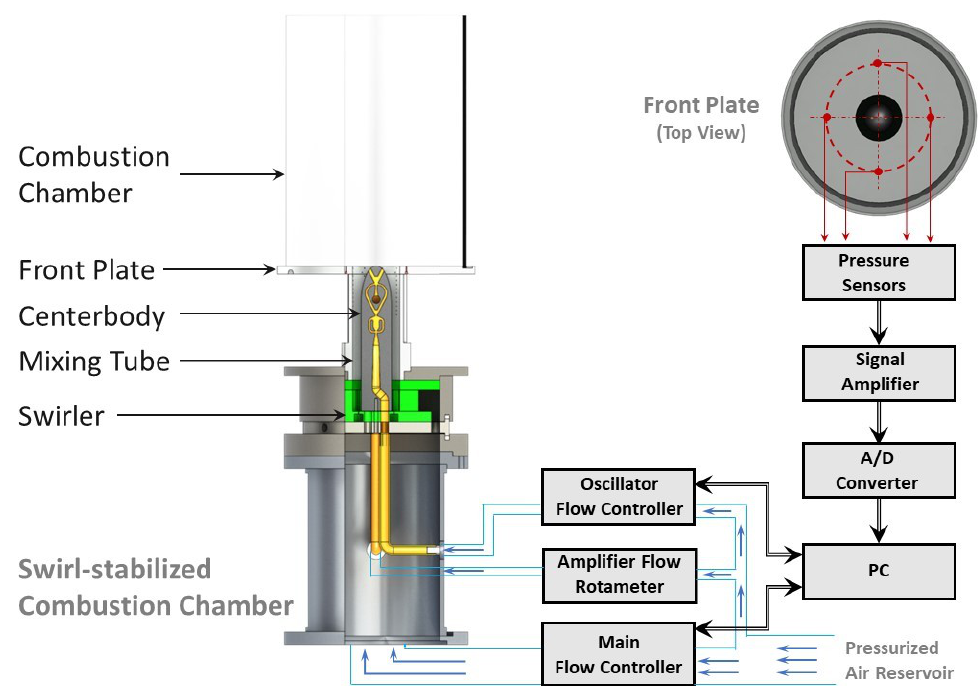
Figure 8. Measurement setup for validation of the flow control authority: prototype combustor test rig on the left and pressure measurement chain on the